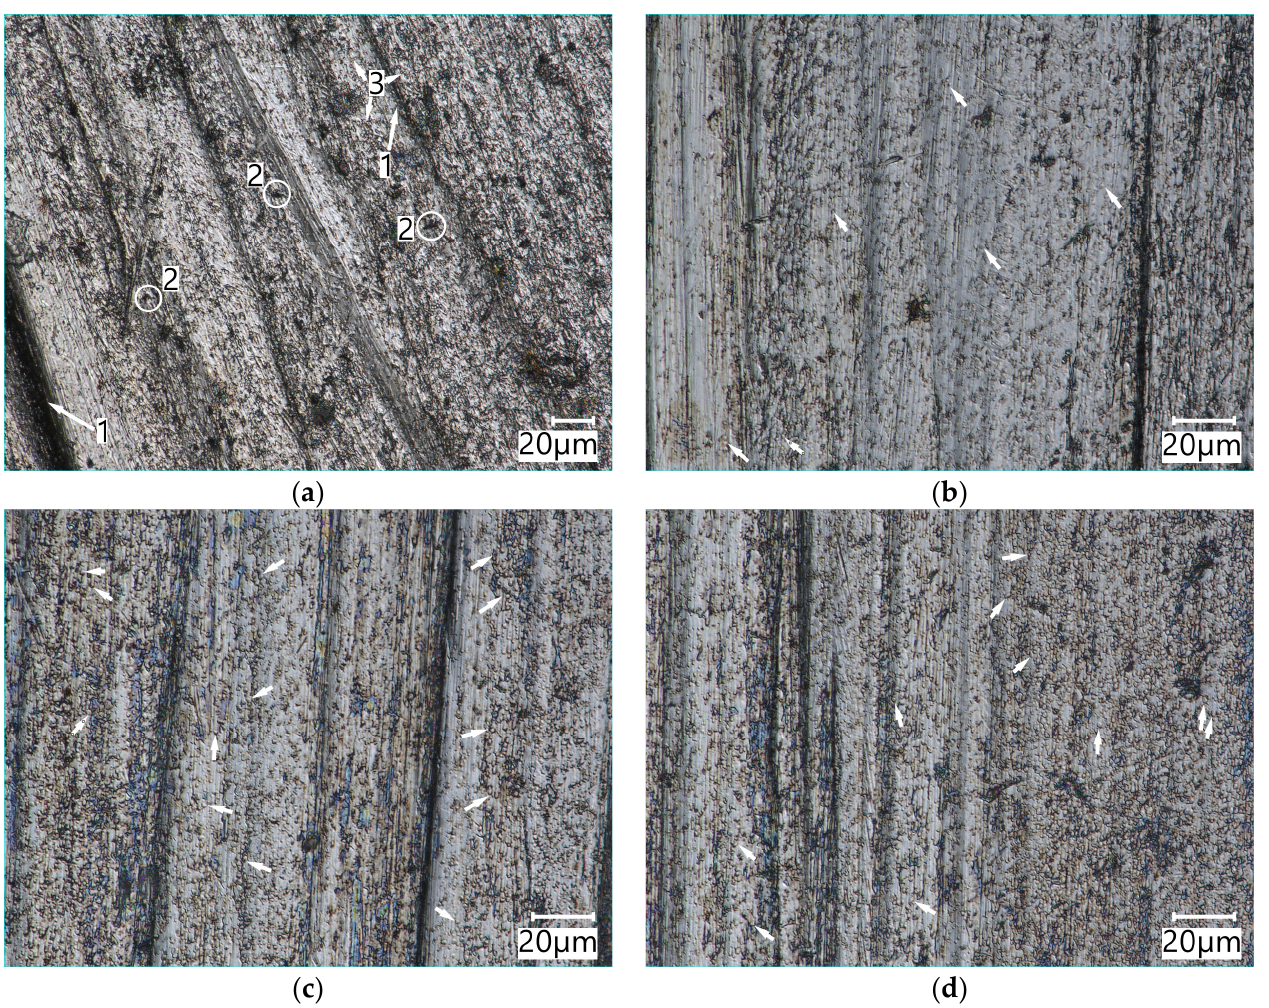
Figure 16. The surface of Vanadis 60 SuperClean steel (O) and Vanadis SuperClean (W) worn in the medium soil ( a ), ( c ) and light soil ( b ), ( d ): the arrows indicate selected carbide precipitates. 1—ploughing, 2—micro ‐ cutting, 3—fine carbide precipitates. Optical light microscopy.